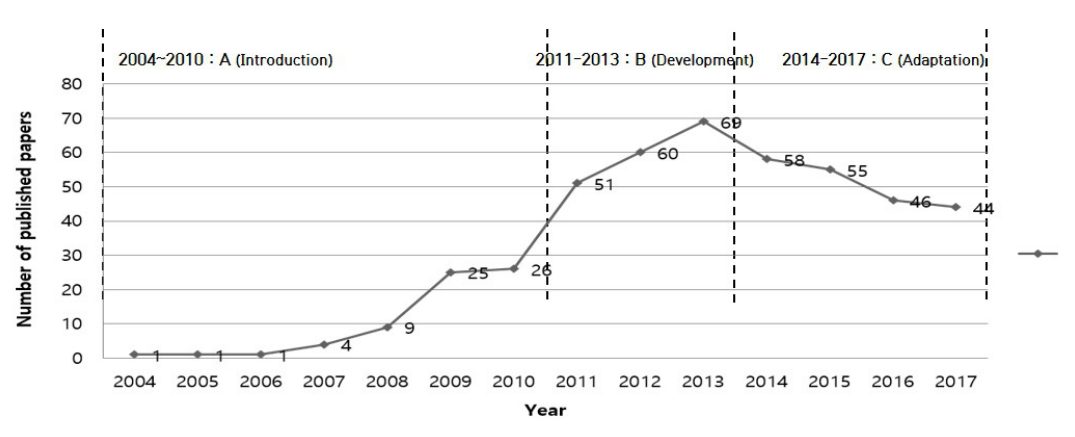
Figure 2. Total number of published papers per